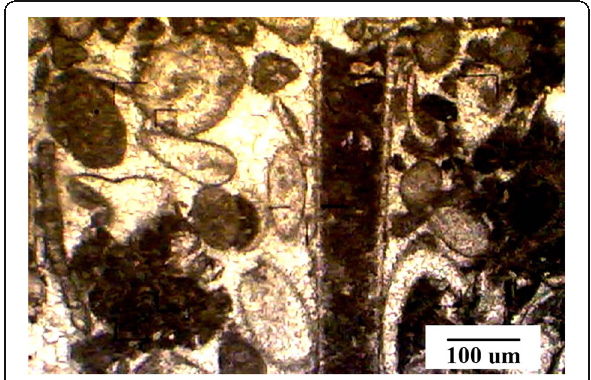
Fig. 10 Biomicrite dolomitic lime-mudstone microfacies showing of nummulites species, miliolids, and others shell fragments scattered in the micritic matrix. Note: Compaction and the micritic envelope, PPL